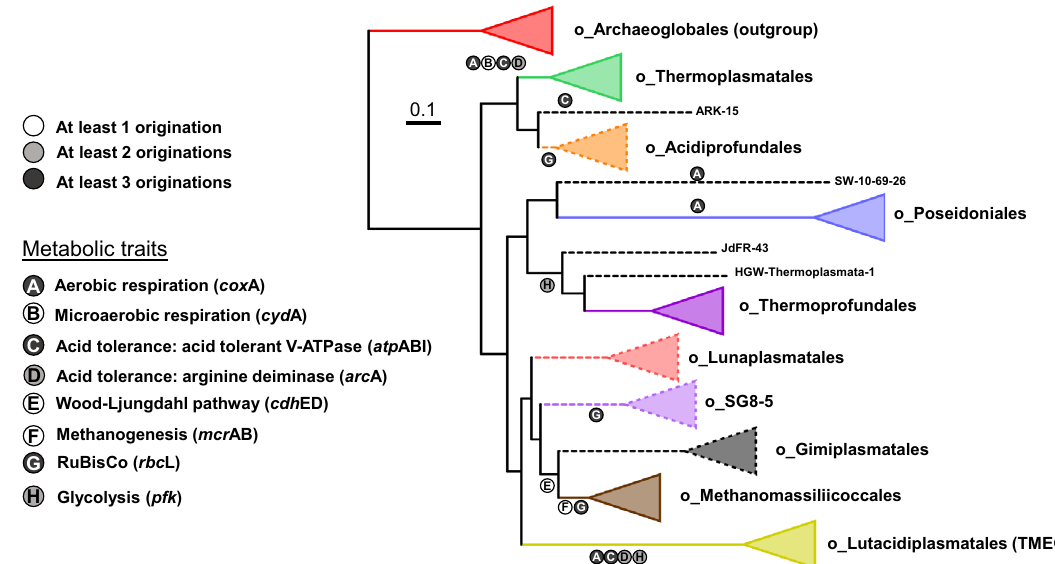
Fig. 4 Evolution of Thermoplasmatota metabolisms. The origins of key metabolisms were mapped on the phylogeny of Thermoplasmatota. Progressive gain and loss of genes between ancestral reconstructions and individual gene tree analysis were used to detect multiple independent lateral acquisitions of the same metabolisms into Thermoplasmatota lineages. The triangles represent collapsed clades. A dotted triangle indicates that this clade consists of less than four representative genomes, so originations may be underrepresented in the LCA of this clade (dotted branch). Marker genes of the selected metabolisms are in parenthesis. cox A (haem-copper oxygen reductase, subunit A; K02274), cyd A (cytochrome bd ubiquinol oxidase, subunit A; K00425), atp ABI (acid) (V/A-type atpase A, B and I subunits; K02117, K02118 and K02123), arc A (arginine deiminase; K01478), cdh DE (acetyl-CoA decarbonylase/